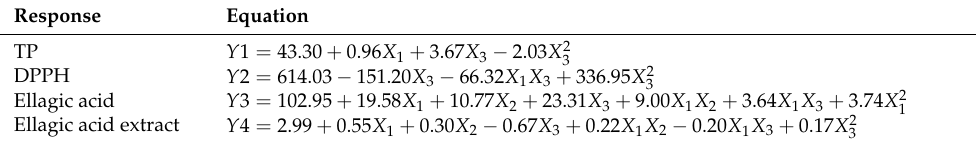
Table 4. 2nd order polynomial equations only with statistically significant coefficients ( p < 0.05).